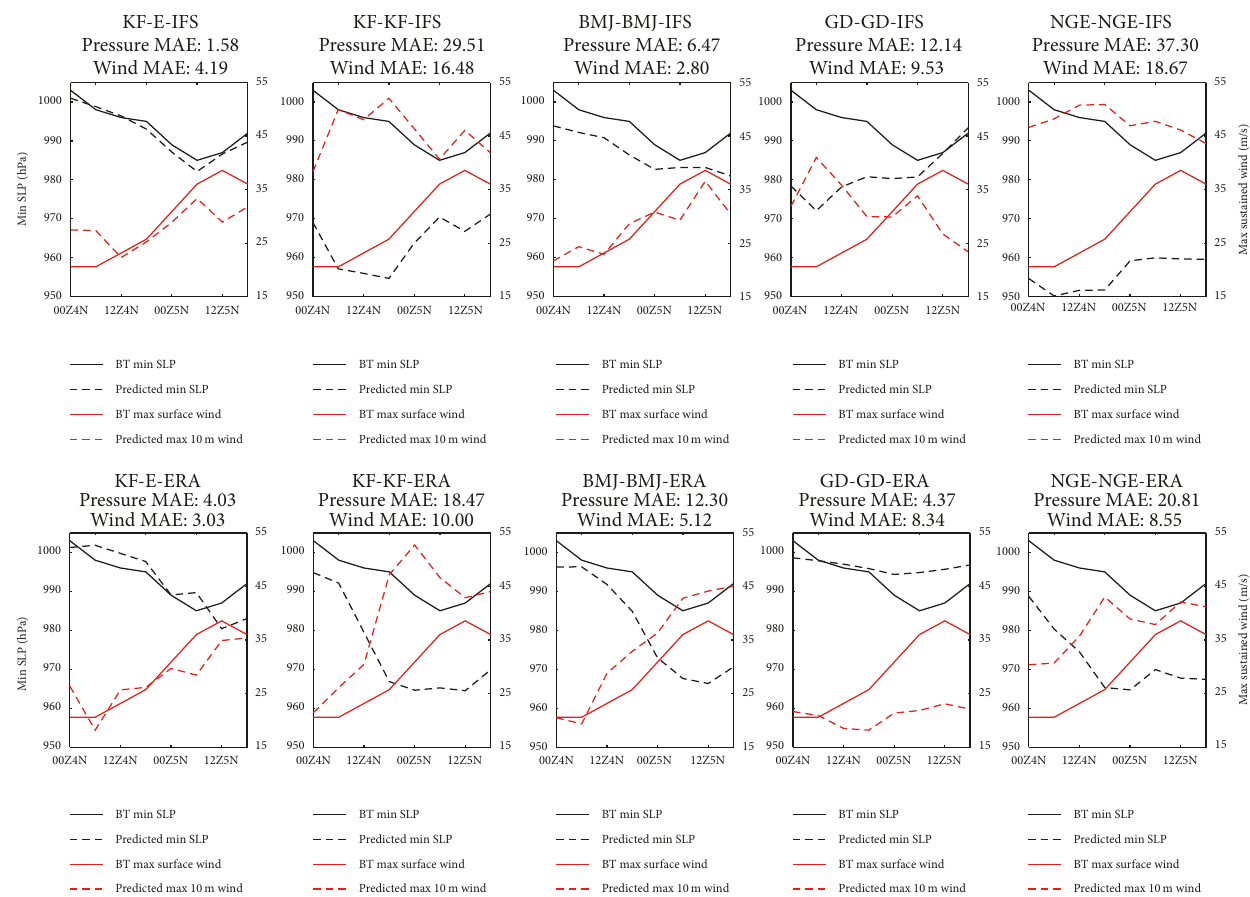
Figure 5: Evolutions of observed (solid) and predicted (dashed) minimum SLP (in black) and maximum sustained surface wind (in red) of Hurricane Tomas from 00UTC on 4 November to 18UTC on 5 November 2010, with respective average MAEs on top of each panel. radar data are hardly available, rainfall amounts for Hurri- cane Tomas are estimated from satellite measurements, and in particular three datasets are considered: TRMM 3B42 (spatial resolution: 0.25 × 0.25 degrees; temporal